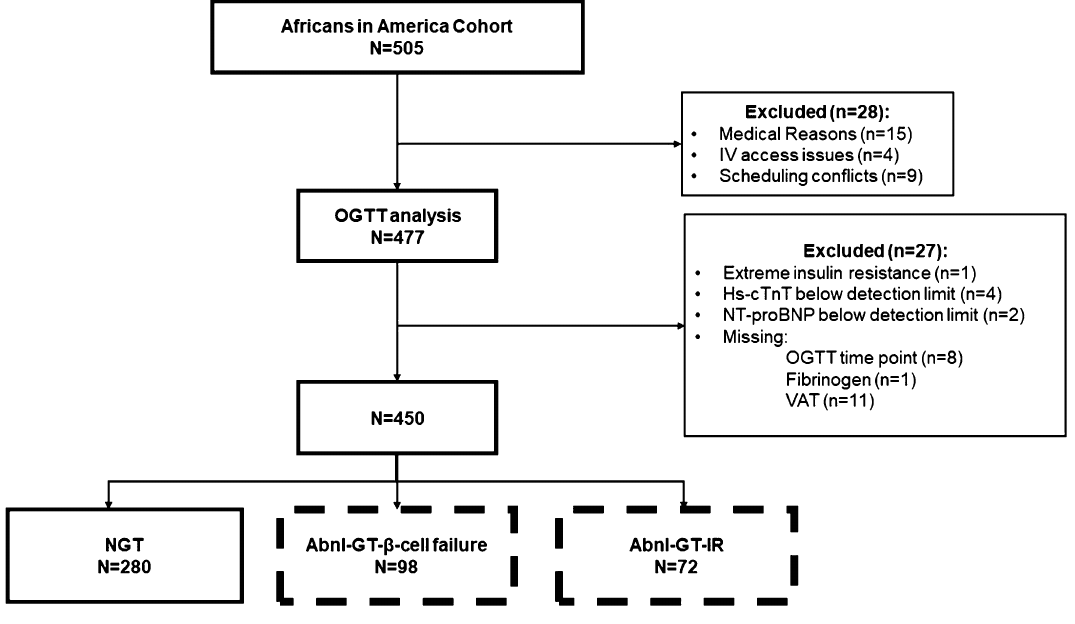
Figure 1. Flow diagram for recruitment and determination of glucose tolerance